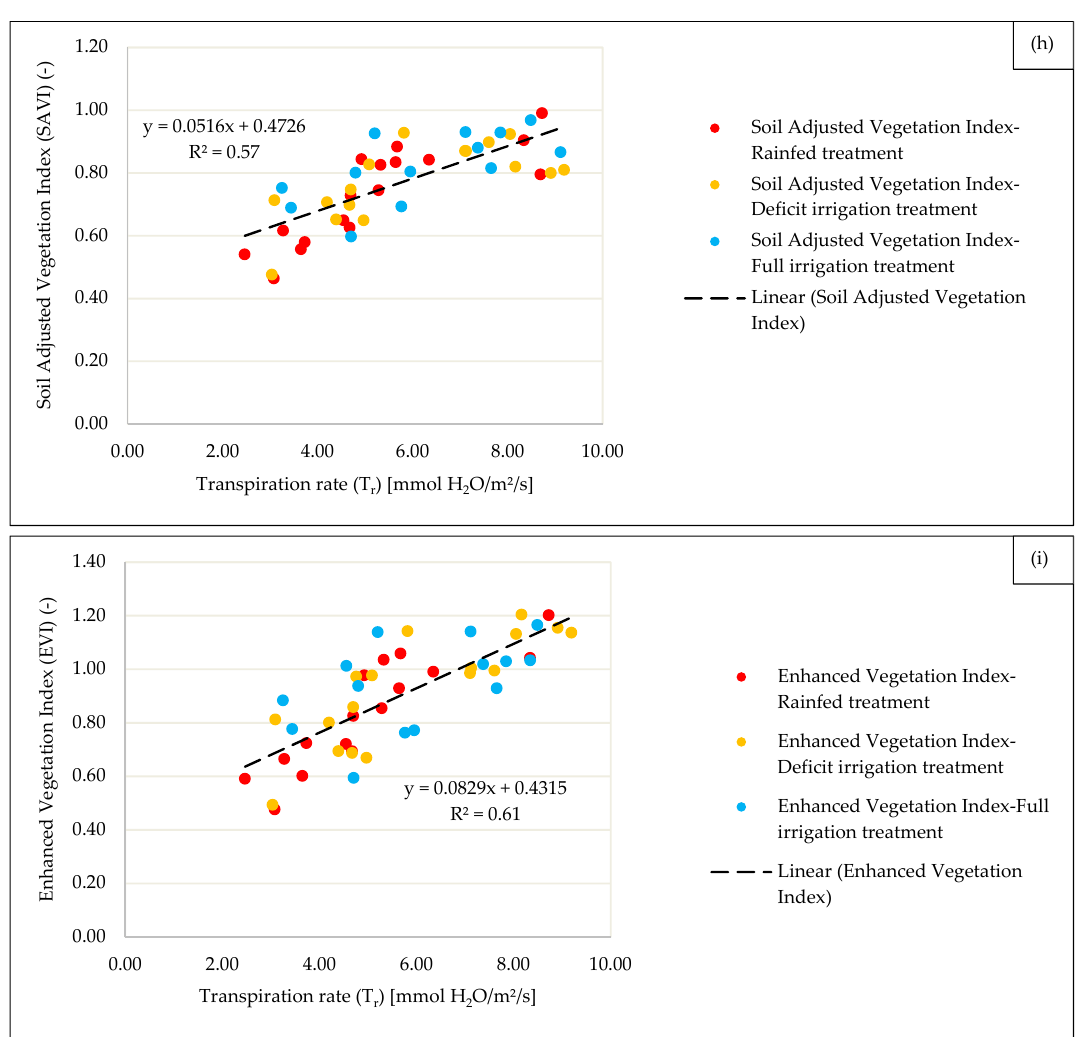
Figure 3. Linear regression parameters between net assimilation (a, b, c), stomatal conductance (d, e, f) and transpiration rate (g, h, i) leaf exchange parameters and spectral (Normalized Difference Vegetation Index (NDVI), Soil Adjusted Vegetation Index (SAVI), and Enhanced Vegetation Index (EVI)) vegetation indices, respectively.